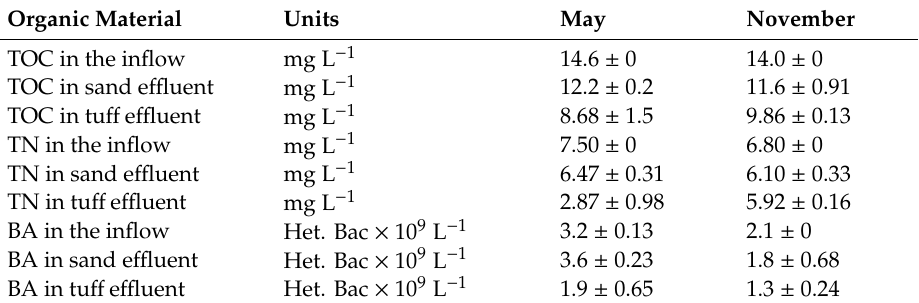
Table 2. Water quality results of the secondary e ffl uent wastewater (WW) inflow and the outflow after 48 h of percolation through the columns of media. Numbers are shown as averages (with STDV) of each quadruplicate